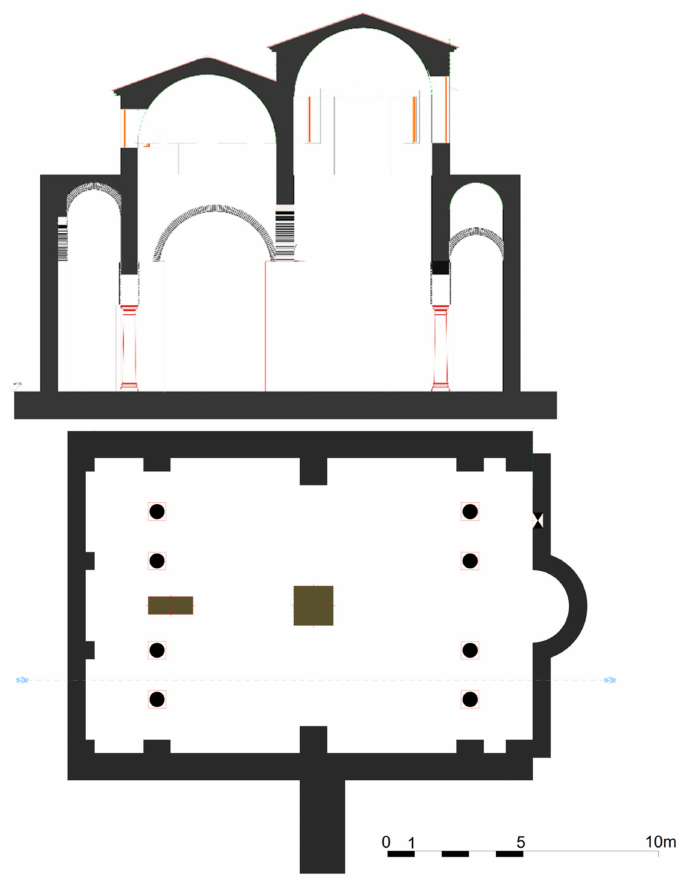
Figure 6. Plan layout and longitudinal section of St Nicholas’s church of Mesopotamia. Provision courtesy of Arch. Arsim Murseli, UBT